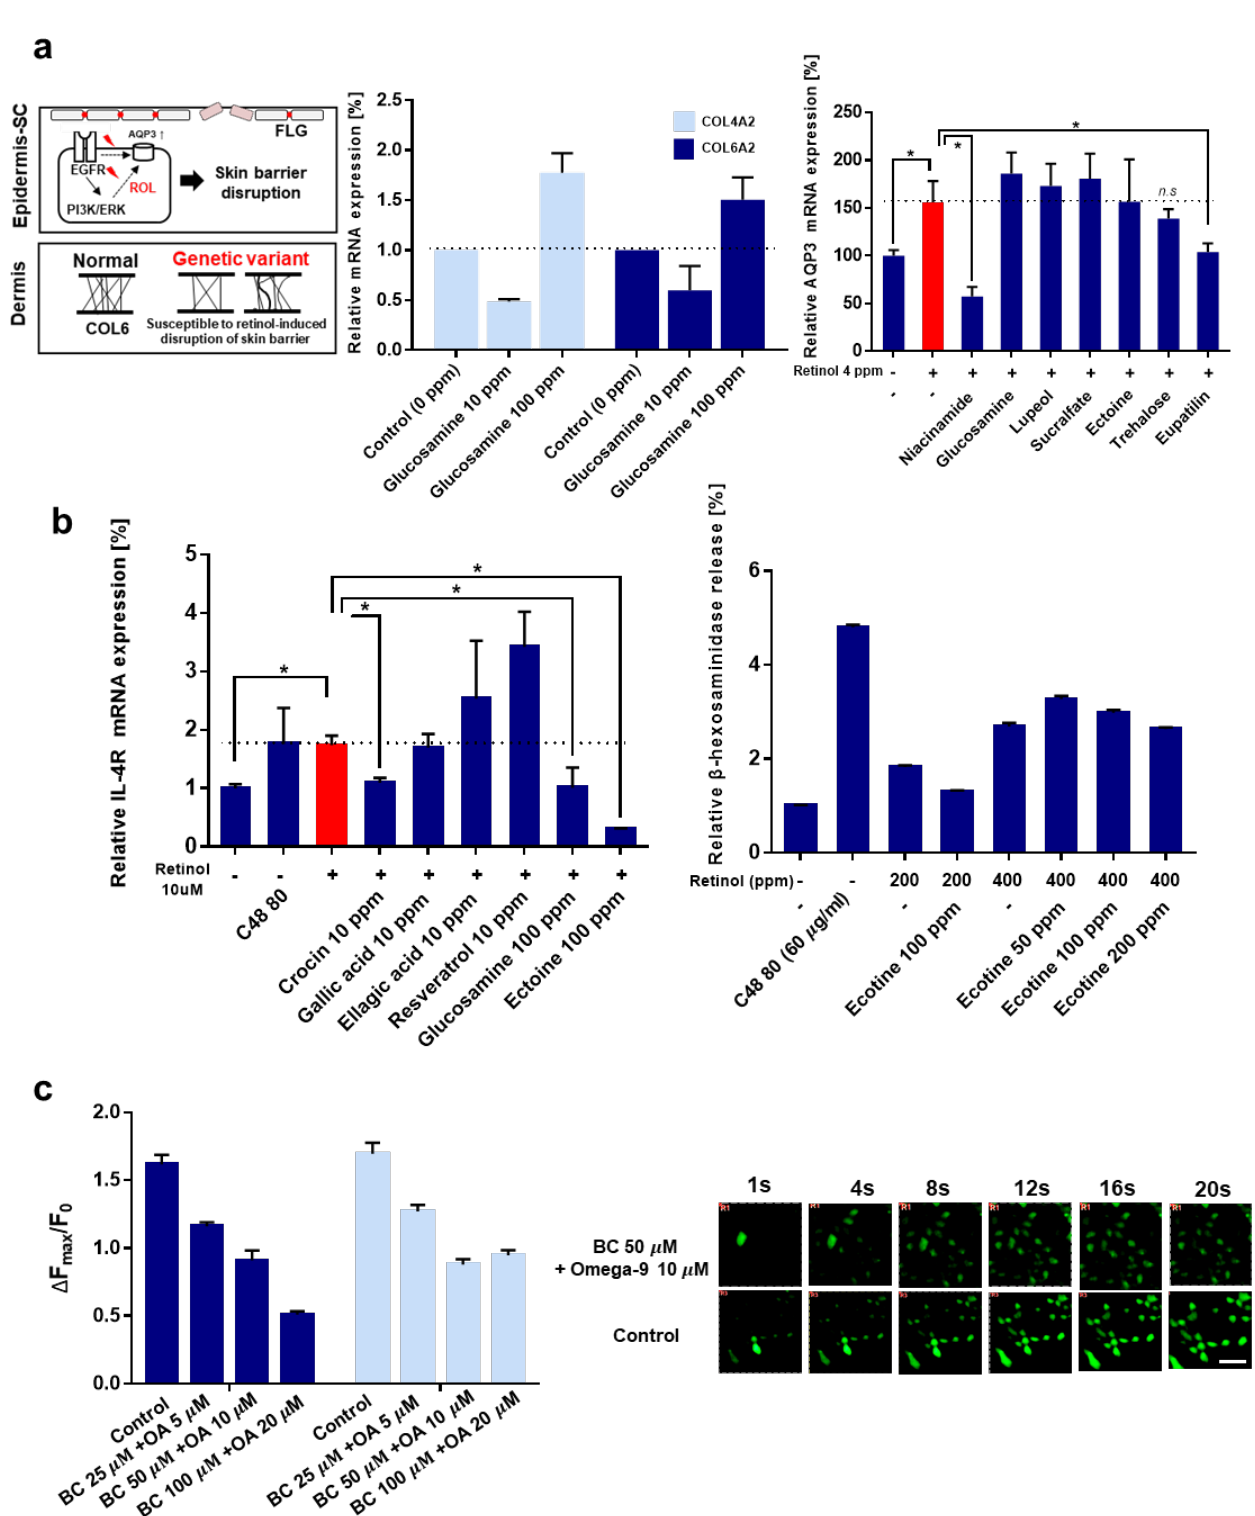
Figure 3. The analysis for mRNA expression to screen anti-irritants that could modulate irritation-associated molecular pathogenesis. ( a ) Investigation for skin barrier disruption-associated molecular pathogenesis. Schematic diagram for the approach for genetic modulation for retinol (ROL)-induced skin barrier disruption. (left) The relative mRNA expression of COL4A2 and COL6A2 when fibroblasts were treated with glucosamine (middle) and relative mRNA expression of AQP3 (keratinocyte, right). ( b ) Investigation for inflammation (mast cell driven)-associated molecular pathogenesis. Rel- ative mRNA expression of IL-4R when RBL-2H3 was treated with 10 µM retinol and various candidates. ( c ) Neurogenic